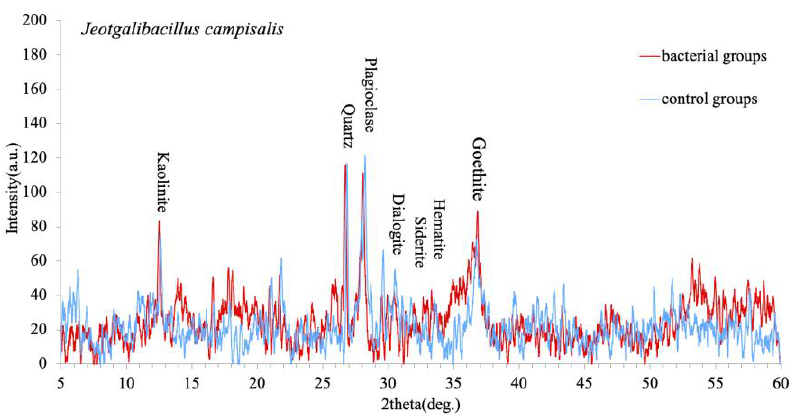
Figure 6. Mineral composition changes of ferromanganese nodules crust.